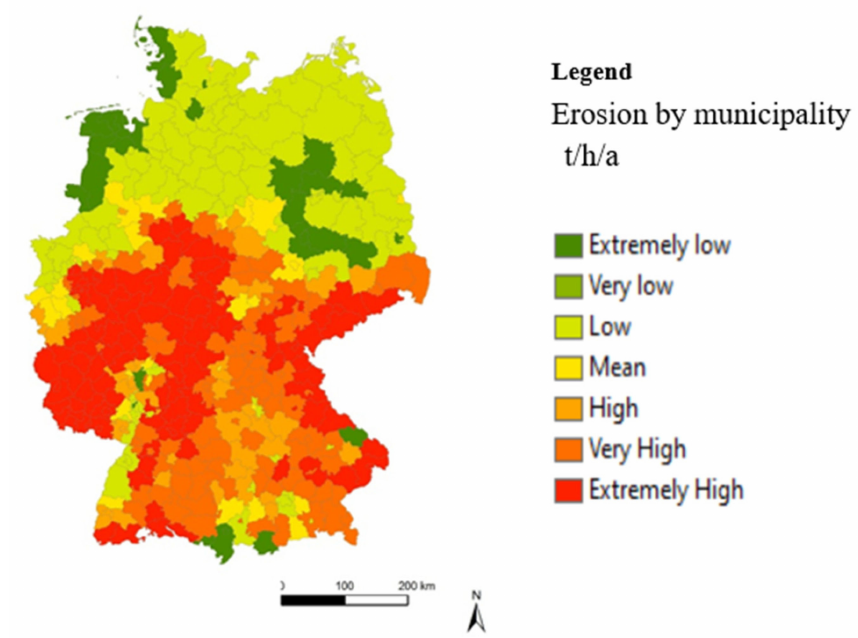
Figure 7. German erosion potentials by municipalities in tons per hectare per annum, according to the German federal ministry for geosciences and raw materials before our reference state.